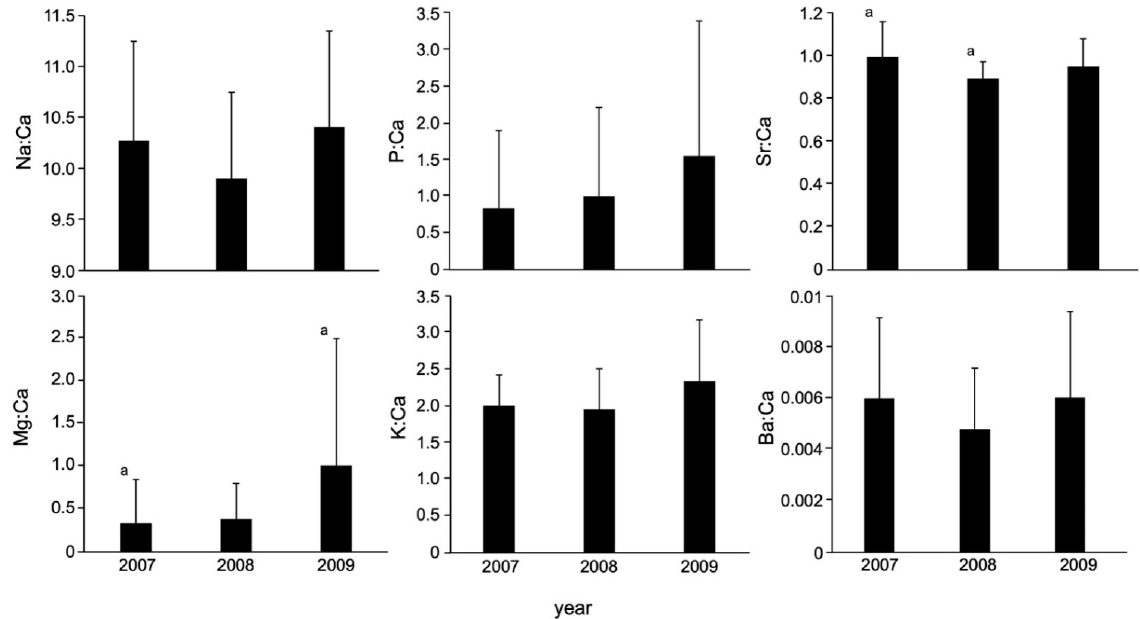
Figure 1. Otolith elemental ratios (mean ± SD) for three years (2007, 2008, 2009) in the Japanese eel ( Anguilla japonica ) collected in Oi River, Shizuoka Prefecture, Japan. The letter a indicates statistically significant difference at p < 0.05.